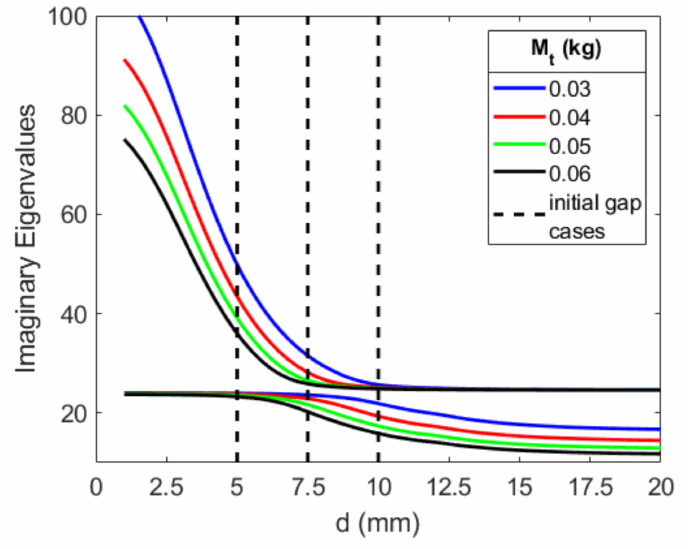
Figure 21. The initial gap’s effects on the coupled natural frequency of varying tip